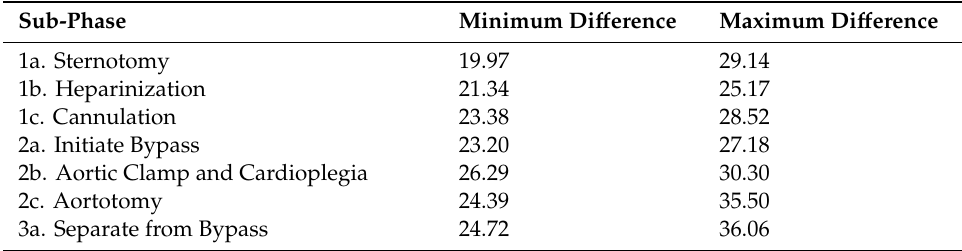
Figure 3. Relationship between mean HR and mean rSO 2 . A significant positive correlation was found between HR and rSO 2 data. Each data point represents the same 60-second interval of HR data and of rSO 2 data. The 177 datapoints shown in this figure encompass all phases included in Table 1. Table 2. Minimum and maximum di ff erences between HR and NIRS distributions across